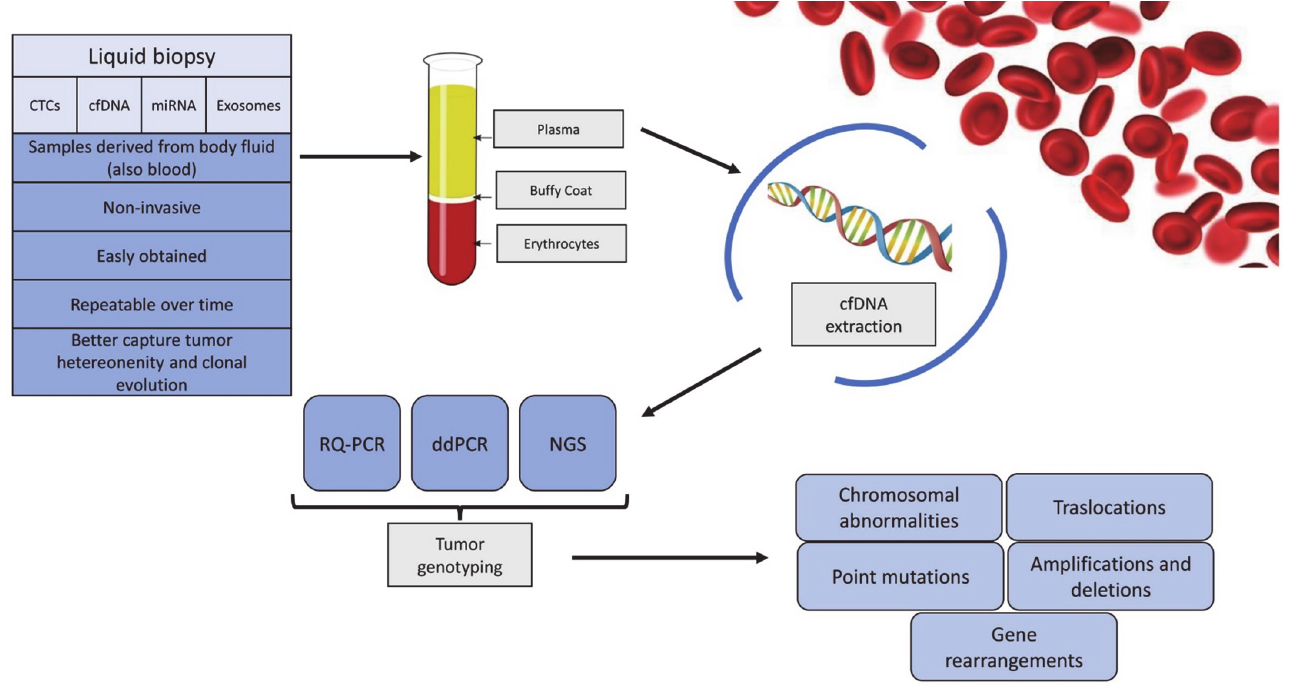
Figure 3. cfDNA as novel compartment for molecular MRD monitoring in ALL.